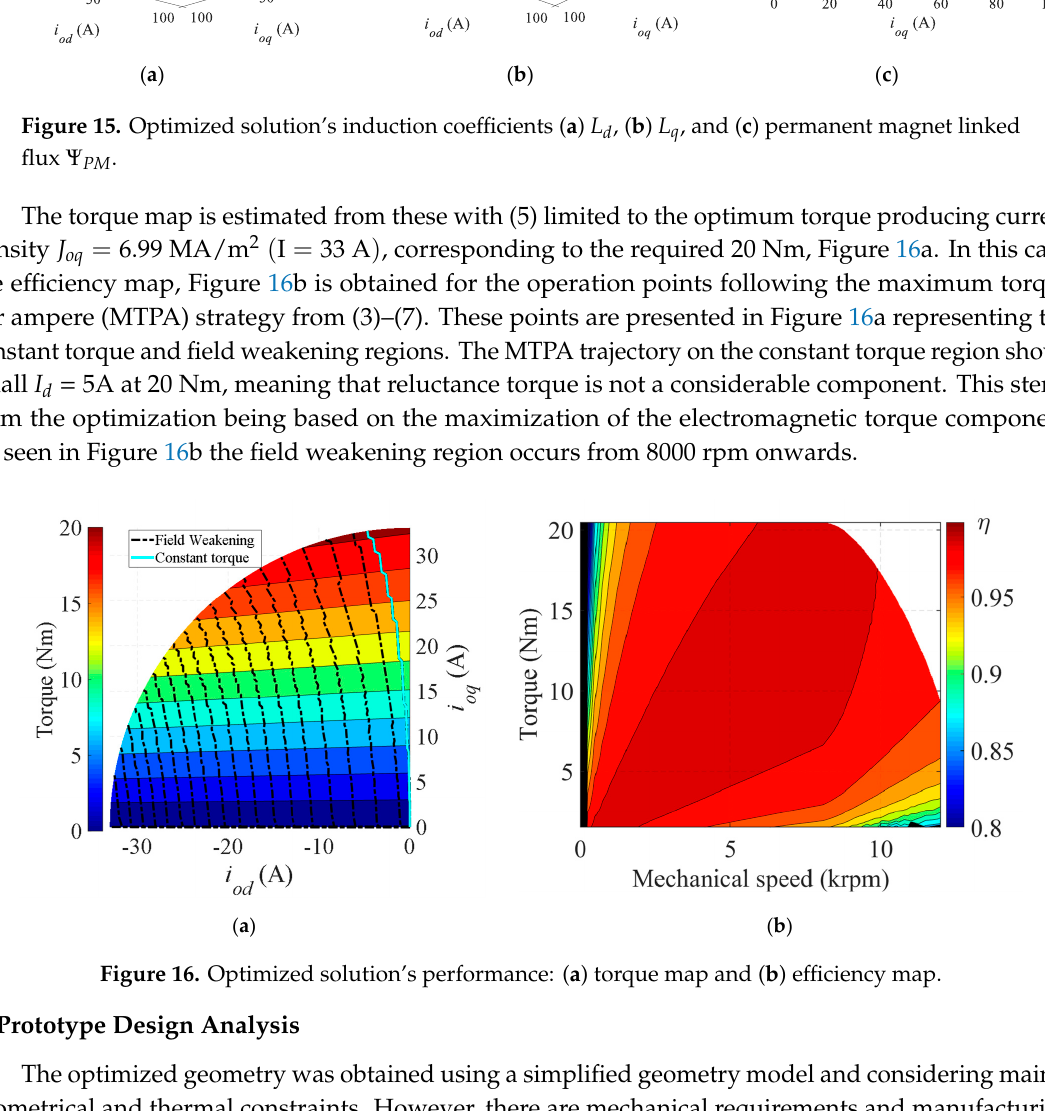
Figure 14. Optimized solution for 20 Nm: ( a ) geometry, ( b ) distribution of magnetic flux density, and ( c ) 3D geometry. The selected optimized solution is further analyzed to estimate the IPMSM performance. The number of stator windings turns 20 to achieve the desired voltage/speed characteristic of around 8000 rpm base speed at 380 V, the inverter’s maximum voltage. The permanent magnet linked flux, 𝛹 𝑃𝑀 , and d-q linked fluxes 𝛹 𝑑 , 𝛹 𝑞 are calculated with the FE model, considering cross-saturation from which 𝐿 𝑑 and 𝐿 𝑞 maps are determined from (11) and (12), Figure 15.